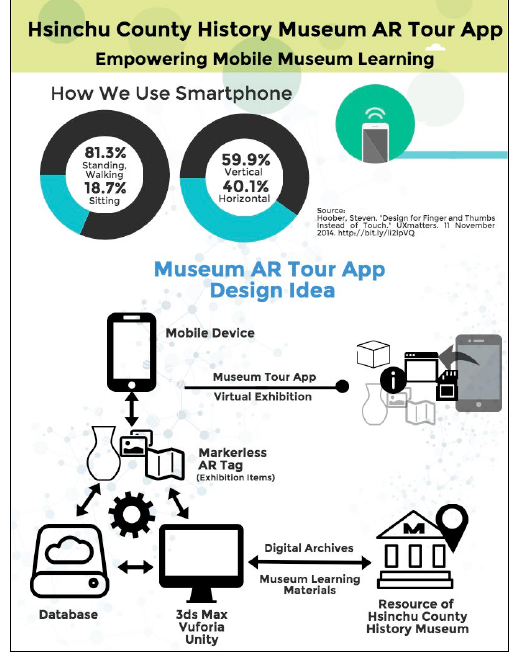
Figure 8. Museum AR Tour App Design Idea